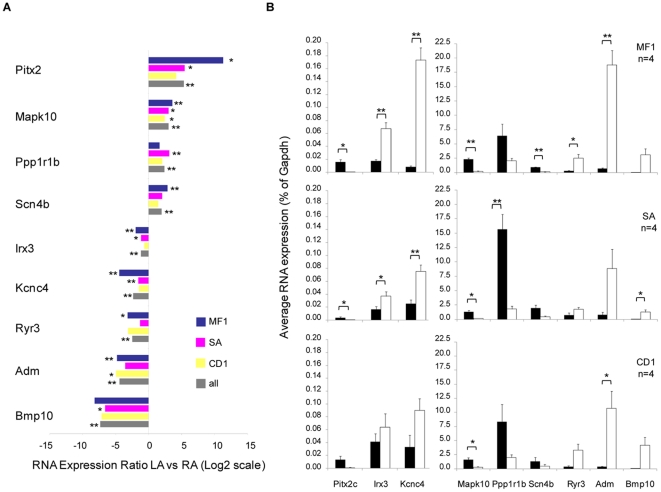
RT-qPCR validation of the differential expression of candidate genes in left and right atria from wild-type mice of three different strains.
A Relative Log2 expression ratios between LA and RA in MF1 mice (blue, n = 4), Swiss-Agouti mice (pink, n = 4), CD1 mice (yellow, n = 4), and in wild-type mice (grey, n = 12). B Corresponding average mRNA expression in left (black) and right (white) atrial tissues of MF1, SA, and CD1 mice (n = 4 each). Gapdh was used as control. Error bars indicate standard error of the mean (SEM). Statistically significant differences as assessed by unpaired Student's t-test are represented by asterisks (*P<0.05, **P<0.01).